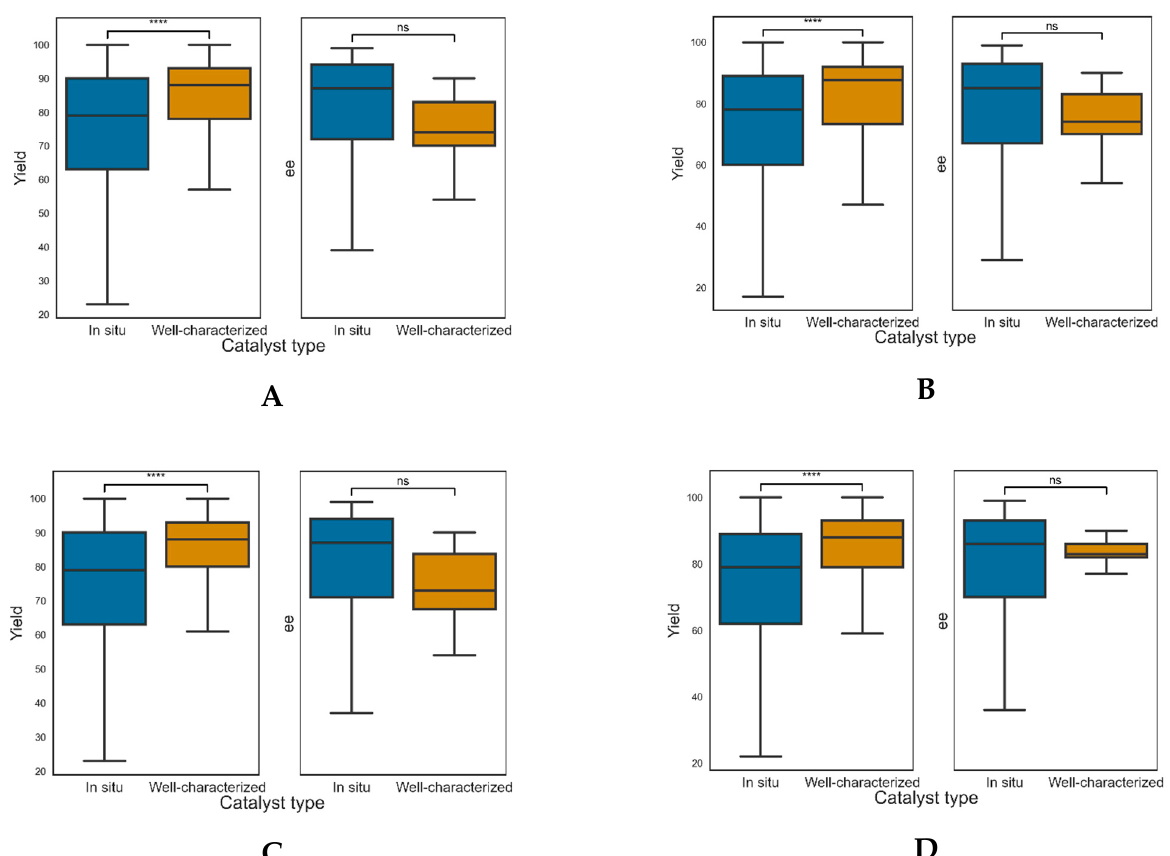
Figure 17. General comparison of yield and ee for well-characterised and in situ protocols. Yields and ee of well-characterised vs. in situ catalysts. Statistical analysis was performed using Student’s t -test ( p = 1.47 × 10 − 11 , 0.58). ( A ) Aldehydes yields and ee of well-characterised vs. in situ catalysts. Statistical analysis was performed using Student’s t -test ( p = 1.84 × 10 − 7 , 0.83). ( B ) Alkynes Yields and ee of well-characterised vs. in situ catalysts. Statistical analysis was performed using Student’s t -test ( p = 8.91 × 10 − 14 , 0.52). ( C ) Amines Yields and ee of well-characterised vs. in situ catalysts. Statistical analysis performed using Student’s t -test ( p = 1.77 × 10 − 13 , 0.56) ( D ). Symbol Meaning: ns p > 0.05, **** p ≤ 0.0001 (For the last two choices only).